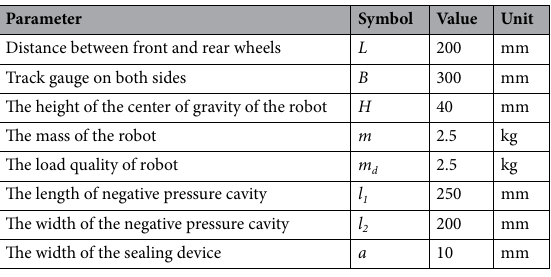
Table 1. Basic parameters of wall-climbing